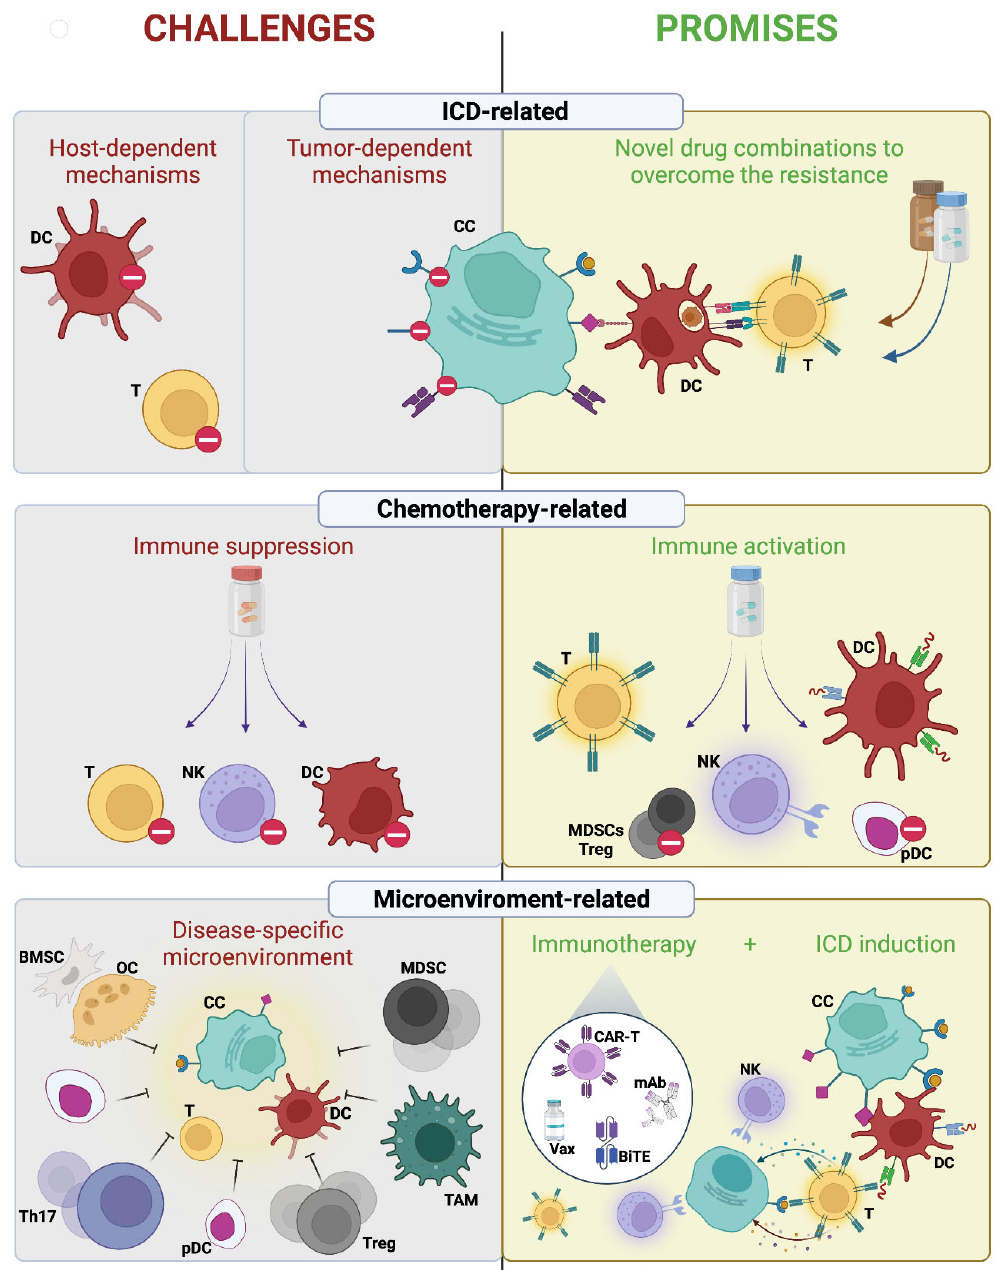
Figure 3. The challenges and promises of immunogenic chemotherapy in multiple myeloma. Sev ‐